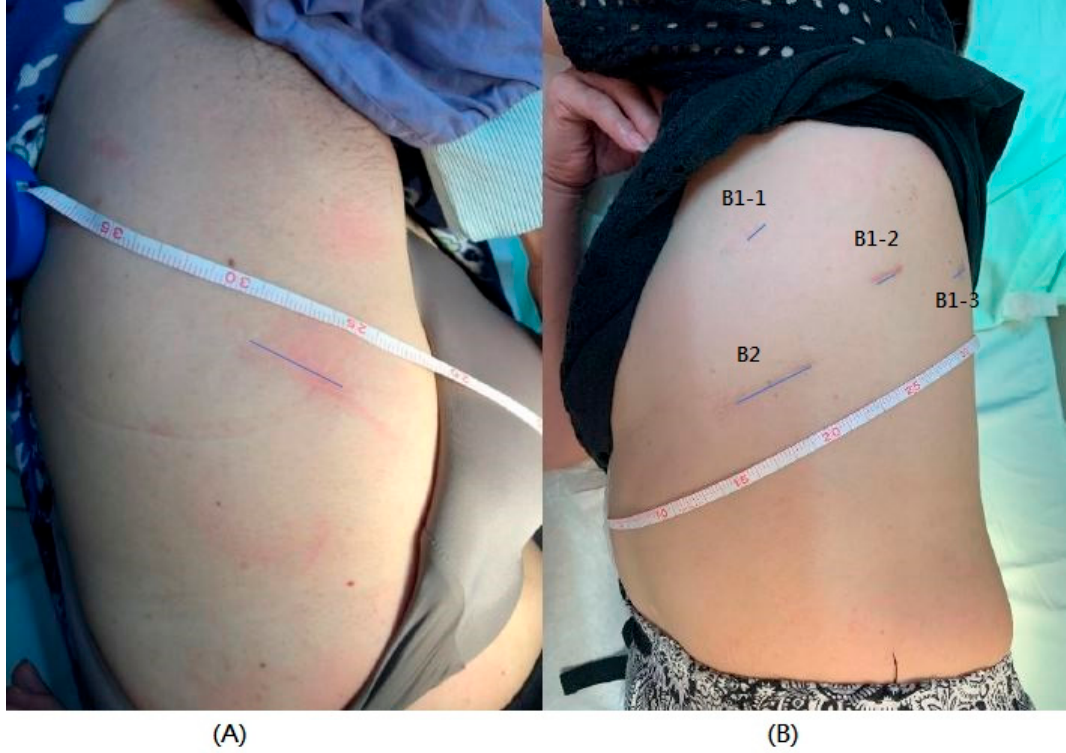
Figure 1. The port placement of VATS ( A ) and RATS ( B ). The thoracoscopic lobectomy was performed via single port (A) approach, whereas the robotic-assisted lobectomy was performed under the Da Vinci Si or Xi system with three robotic arms (B1-1, B1-2, B1-3) and a 3-cm utility incision (B2) along the anterior costo-phrenic region as the assistant port and specimen retraction. The wound would be enlarged if necessary during retraction of the specimen according to the size of the specimen (( A ) and B2).